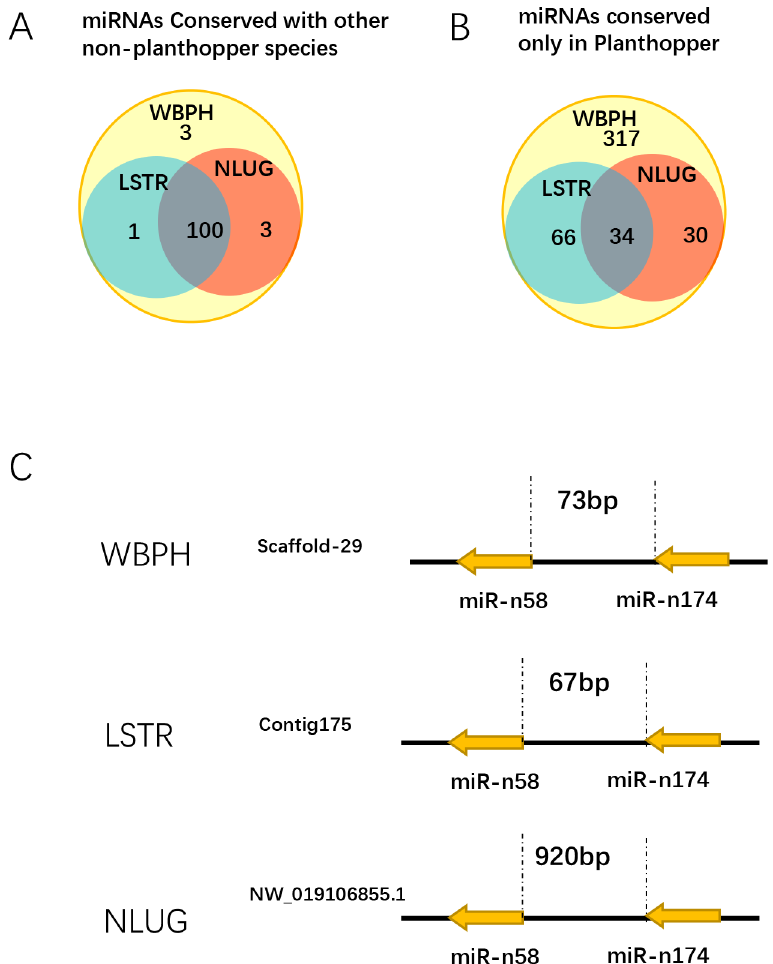
Fig 5. WBPH miRNA homologs in NLUG and LSTR. Homology prediction of identified WBPH miRNA in LSTR and NLUG from (A) non-planthopper and (B) planthopper species. (C) A WBPH miRNA conserved cluster.